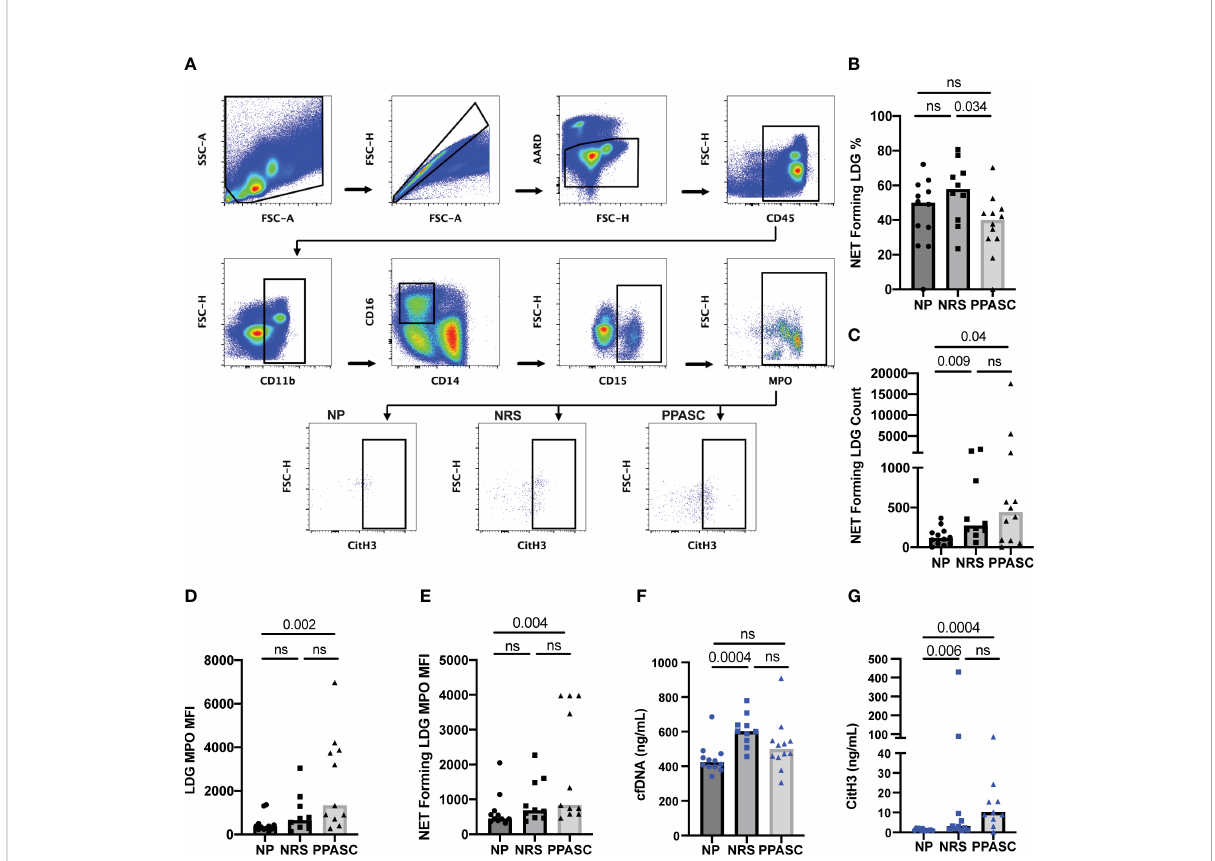
FIGURE 5 Characterization of NET formation in LDGs. Whole PBMC were gated on side scatter area (SSC-A) and forward scatter area (FSC-A) to gate out debris. Forward scatter height (FSC-H) and FSC-A gated out doublets followed by a viability gate using LIVE/DEAD stain and FSC-A. Leukocytes were selected by CD45 expression and CD11b + CD14 - CD16 + fractions were fi nally identi fi ed for LDG based on CD15 expression. NETs were de fi ned as MPO and CitH3 double positive events within the LDG populations for NP, NRS, and PPASC (A) . The percentage (B) and total number (C) of NET forming cells in the LDG fraction was compared across three groups. MFI of MPO on LDGs (D) and NET forming LDGs (E) in NP, NRS, and PPASC groups. cfDNA amounts measured via ELISA in NP, NRS, and PPASC groups (F) . CitH3 amounts measured via ELISA in NP, NRS, and PPASC groups (G) . Graphs are shown as bar with scatter dot plots. Comparisons between groups were performed using Mann-Whitney U test. ns, non-signi fi cant, p >